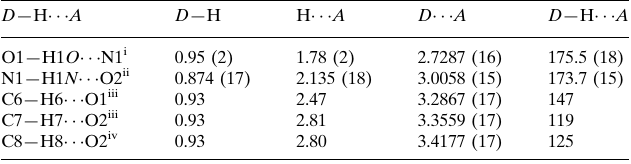
Hydrogen-bond geometry (A˚ , (cid:2)